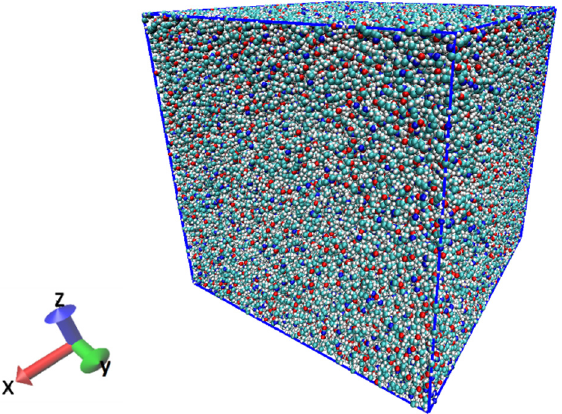
Figure 1. Illustration of the initial system of PA6 consisting of 1000 molecules.